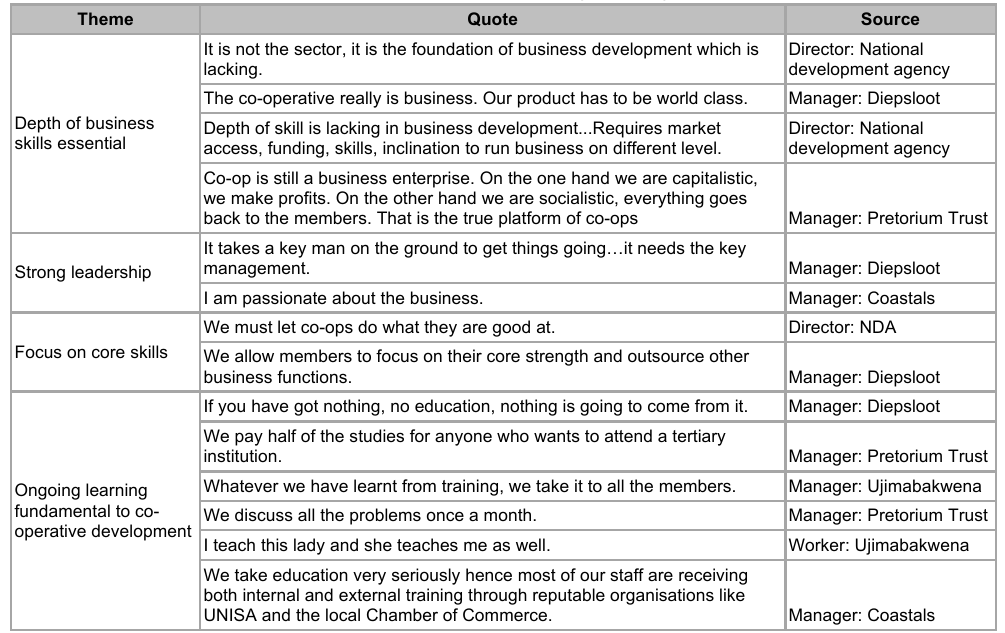
Themes related to knowledge